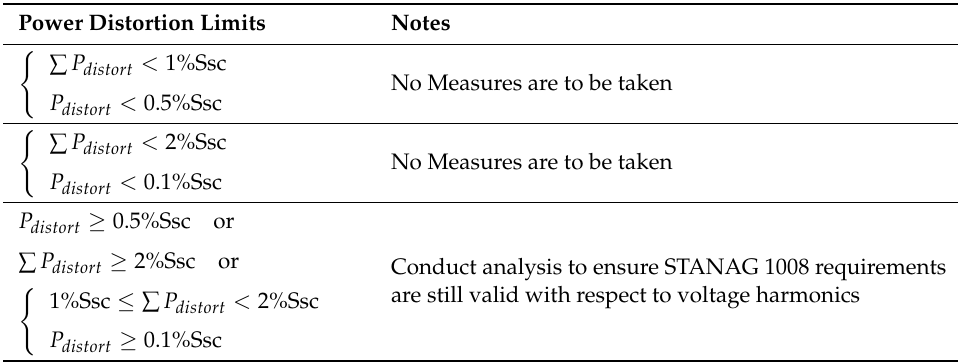
Table 4. The STANAG 1008 requirements regarding maximum power of distorting loads, which does not require further detailed analysis.